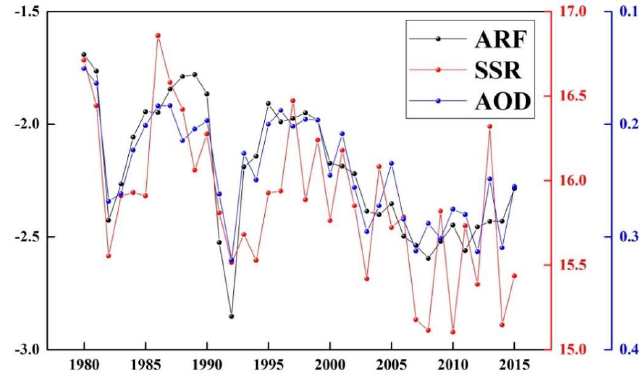
Figure 14. Annual mean values of AOD, SSR and ARFB values during 1980–2015 over Mainland China.